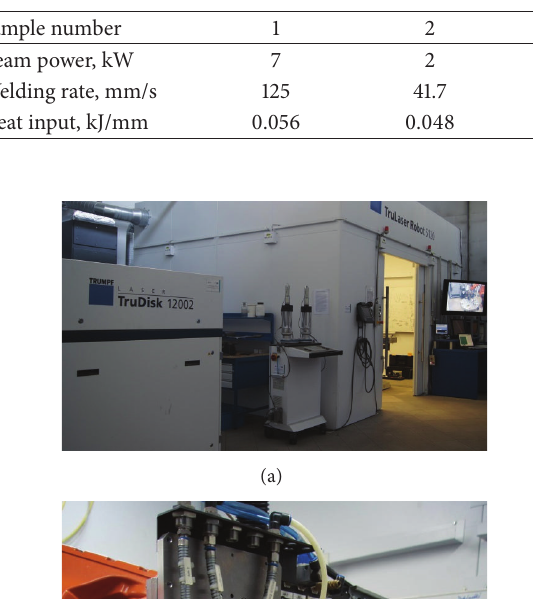
Table 2: Parameters of steel sheet laser welding.